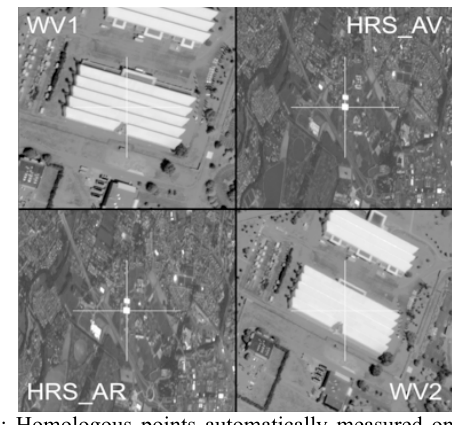
Fig. 5: Homologous points automatically measured on a HRS couple from 2002 and two WorldView images from 2010. ©CNES, 2002, Distribution Spot Image. ©Digital Globe, 2010.